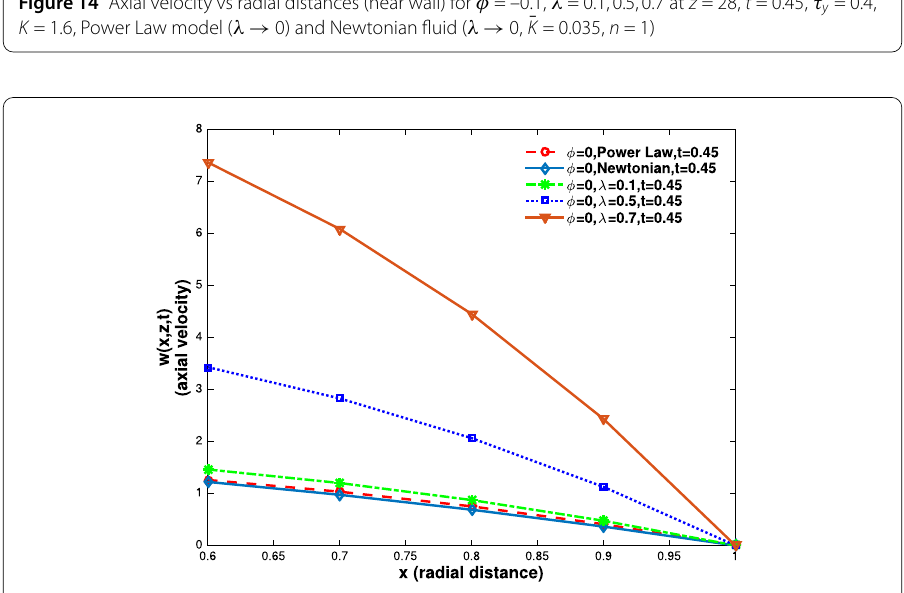
Figure 15 Axial velocity vs radial distances (near wall) for λ = 0.1,0.5,0.7 and φ = 0 at z = 28, t = 0.45, τ y = 0.4, K = 1.6, power law model ( λ → 0) and Newtonian fluid ( λ → 0, ¯ K = 0.035, n =